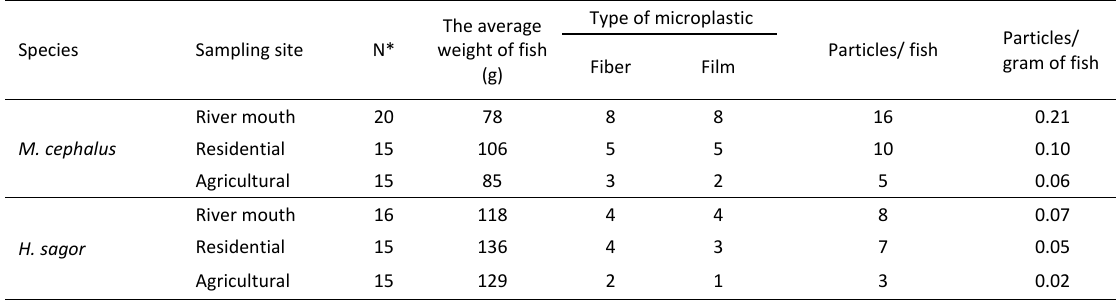
Table 1: The average abundance of microplastic at the alimentary tract of mullet Mugil cephalus and bagok catfish Hexanematichthys sagor according to location and type of microplastics . Species